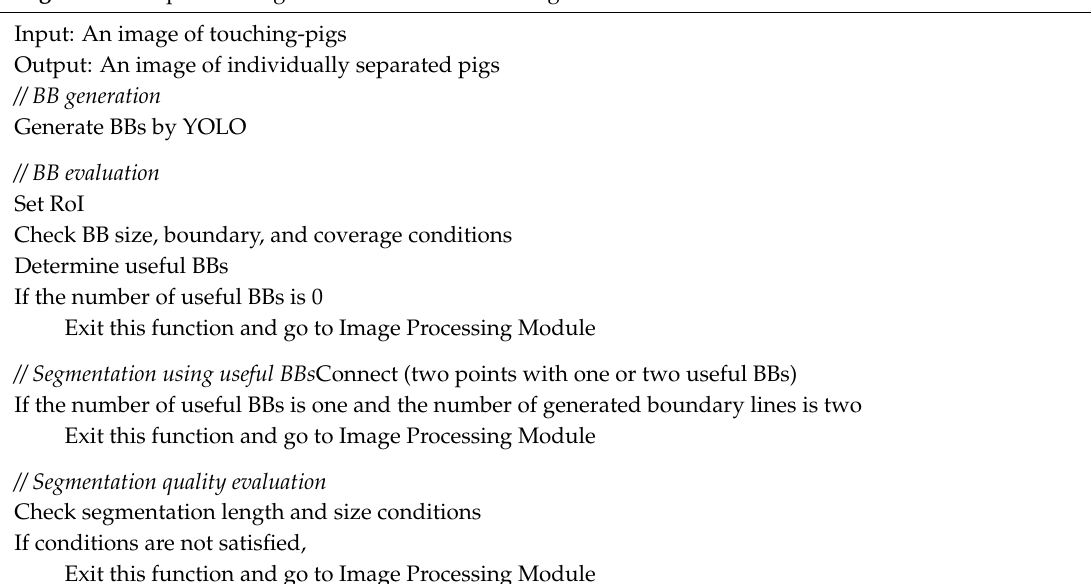
Figure 9. Illustration of the segmentation length and size conditions: ( a ) case of dissatisfaction for the segmentation length condition; ( b ) case of dissatisfaction for the segmentation size condition while satisfying the segmentation length condition; ( c ) case of satisfaction for both the conditions.